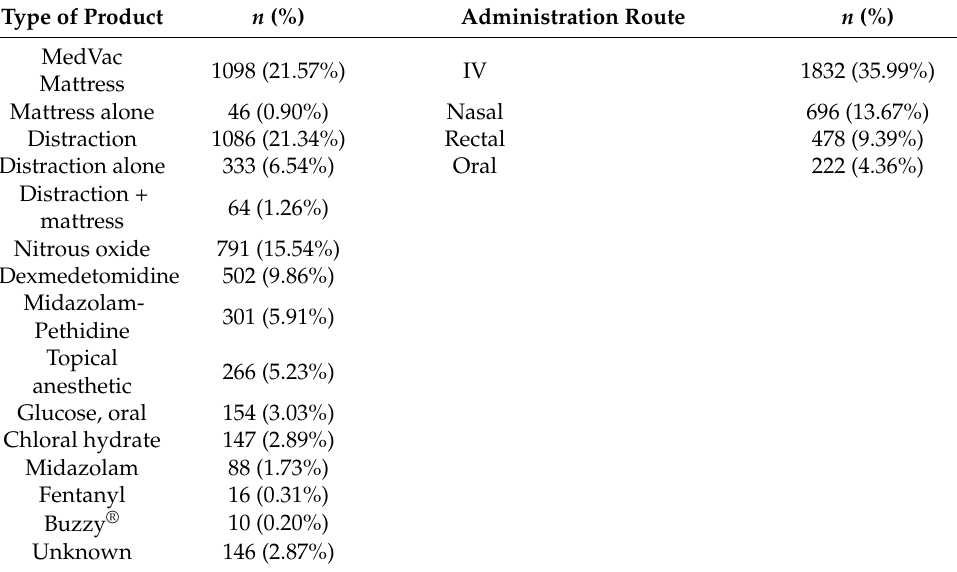
Abbreviations in the table: IV =